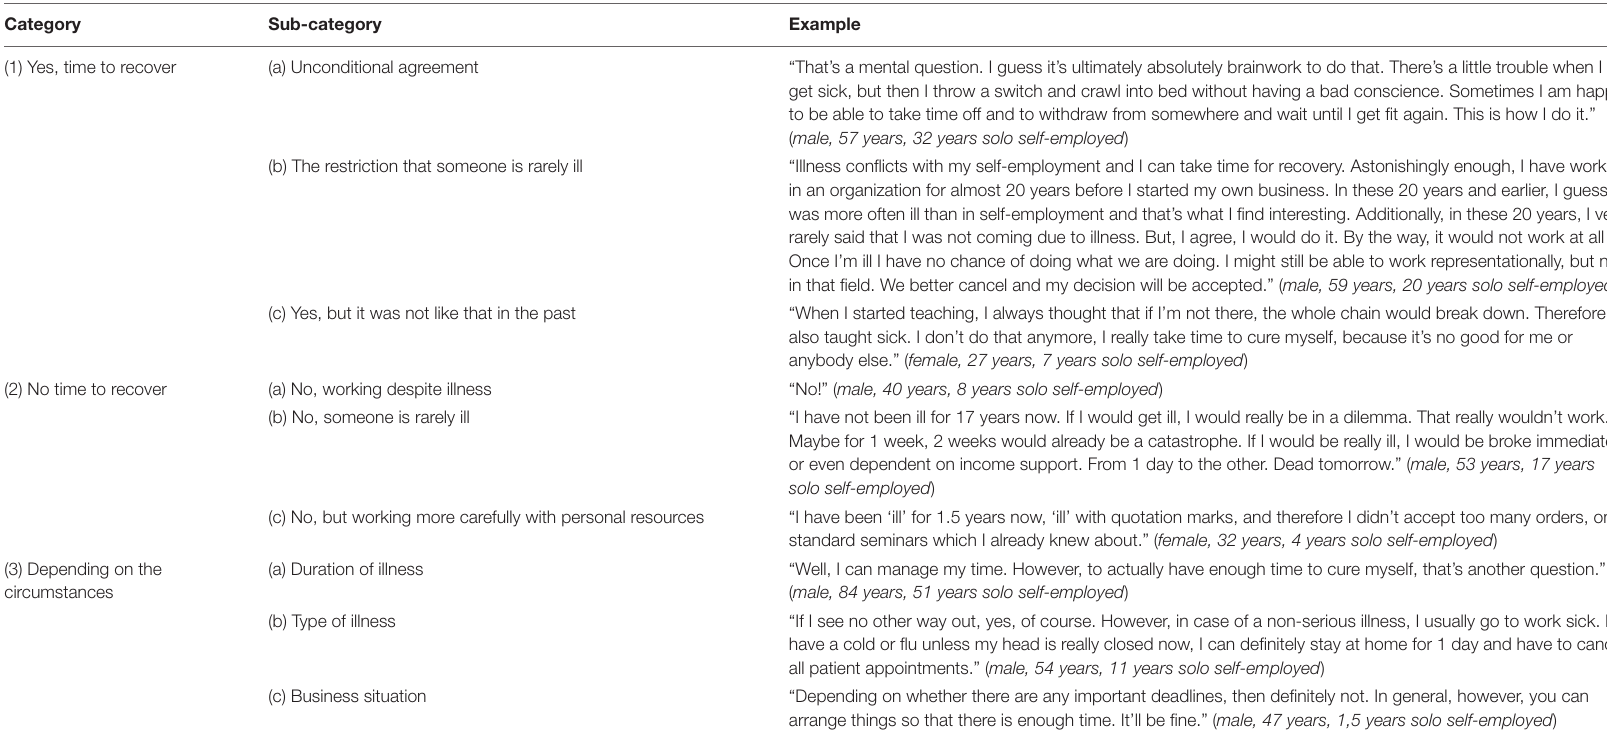
TABLE 1 | Solo self-employment and time for recovery in case of illness.